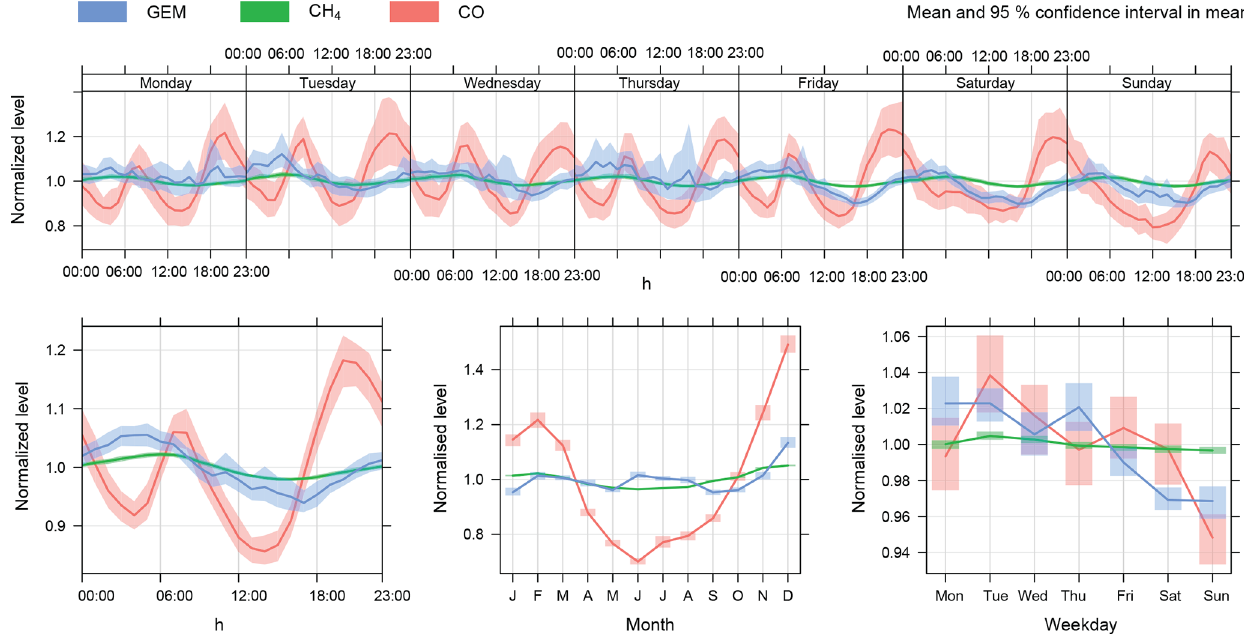
Figure 2. Comparison between normalized GEM, CH 4 and CO levels (divided by overall mean) showing the temporal variation over a weekly, daily, monthly and weekday course. Mean values and 95% confidence intervals are shown. Source: NABEL (FOEN and Empa; BAFU/EMPA,